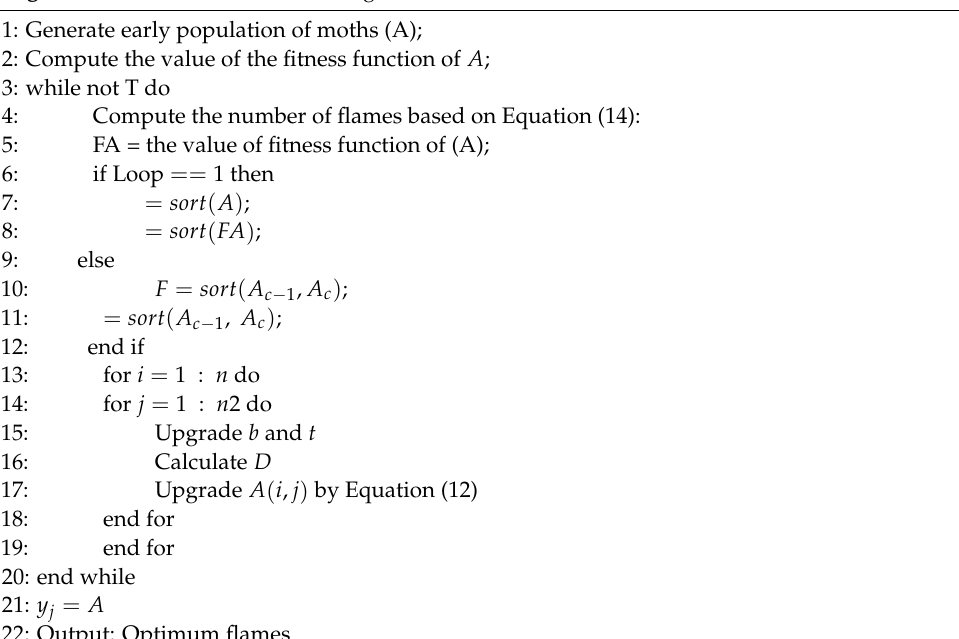
Algorithm 1 Pseudocode of MFO